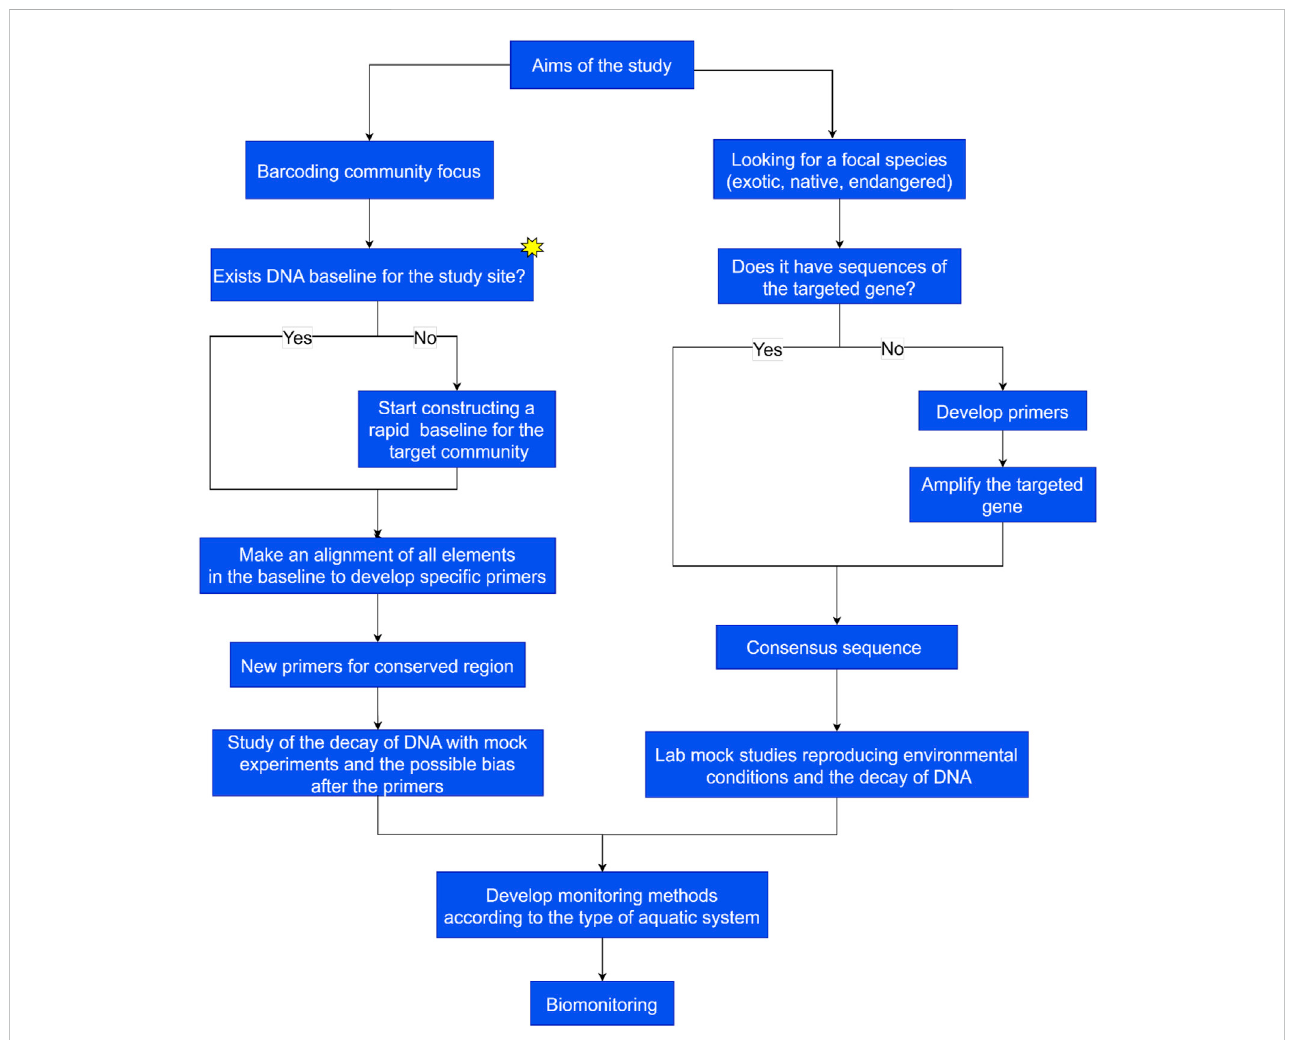
FIGURE 2 Work fl ow for metabarcoding and eDNA studies on freshwater ecosystems. We consider it essential to construct a baseline in the case of community